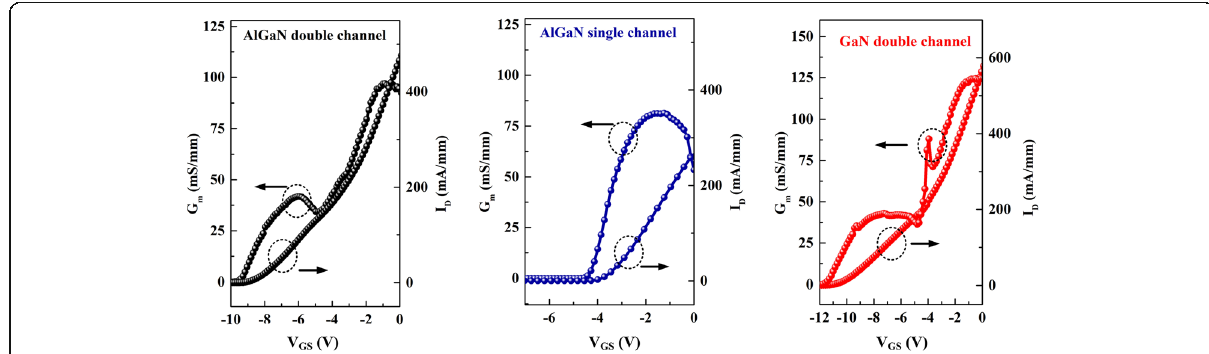
Fig. 6 Transfer characteristics of AlGaN double channel, AlGaN single channel, and GaN double channel HEMTs